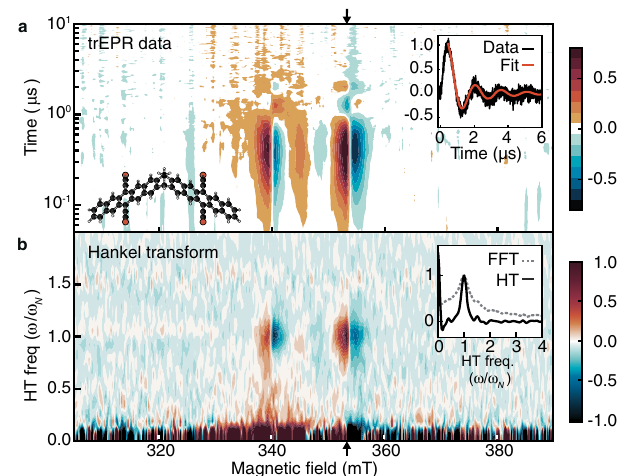
Fig. 1 | The trEPR data for TIPS-BP1' demonstrates long spin-coherence times. a Contour plot of X-band trEPR data for TIPS-BP1' (75 K and 640nm excitation). Source data areprovidedasa Source Data fi le.The structureofthe dimer is shown in thebottom left althoughthe isopropylgroups ofthe TIPSmoieties are removed for clarity (black spheres=C; white spheres=H; red spheres=Si). Inset: Under- damped Rabi oscillations for a representative magnetic fi eld value (353.4mT, black arrows). The signal decay (black line) fi ts well to a damped Bessel function (red line), which isexpected for anorientationally distributedsample. The fi t gives an estimate for the coherence time, T 2 ≈ 1.4 μ s. b The Hankel Transform (HT) pro- videsthenutationspectrumateach fi eldpoint.Inset:TheHTofthetransientshown in the inset of ( a ) peaks much more sharply than the comparable amplitude spectrum from the Fast Fourier Transform (FFT). This resolution enhancement facilitates extraction of the “ Hankel spectrum ” in Fig. 2b, which corresponds to 5 TT 0 ↔ 5 TT ±1